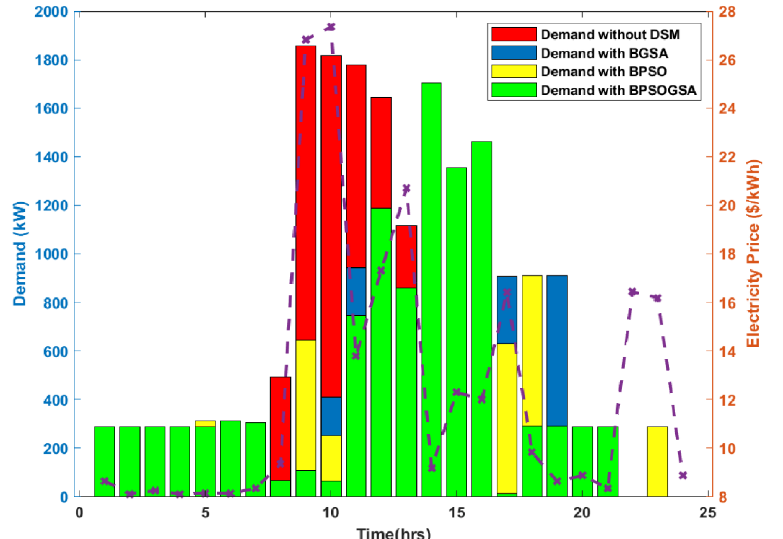
Figure 8. Comparison of demand before and after deployment of DSM with BPSOGSA.